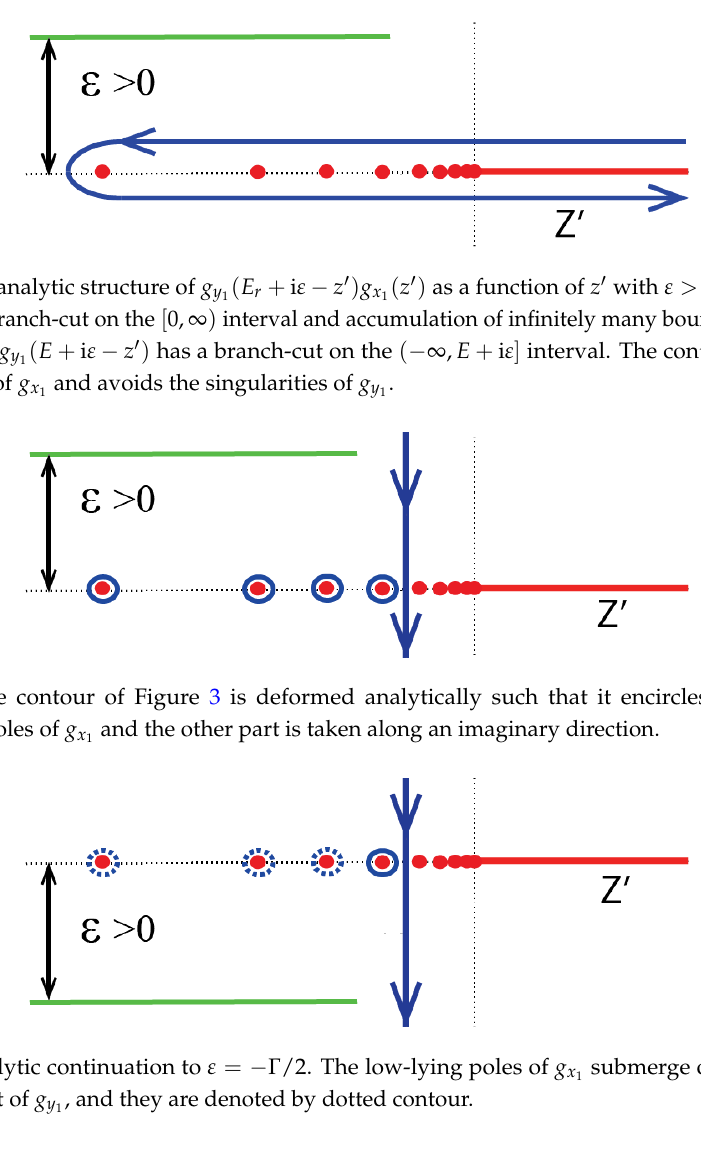
submerge onto the second 1